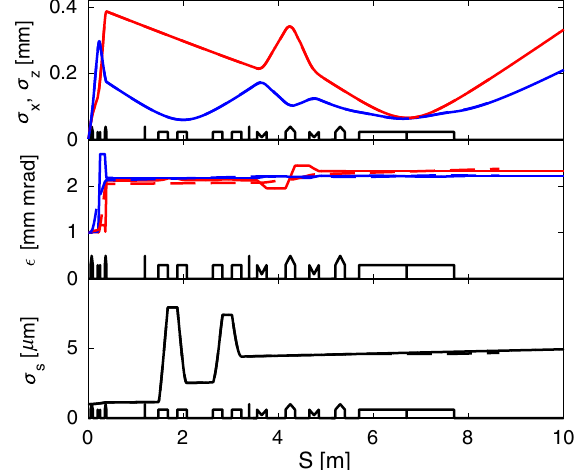
FIG. 3. Beam size envelopes and normalized emittances in the (red) horizontal and (blue) vertical plane, and rms bunch length σ along the COXINEL line. Beam transport simulation in the s nonlinear case with (line) BETA and sympletic 6D tracking and (dashed line) OCELOT, both using the S2I-CM optics